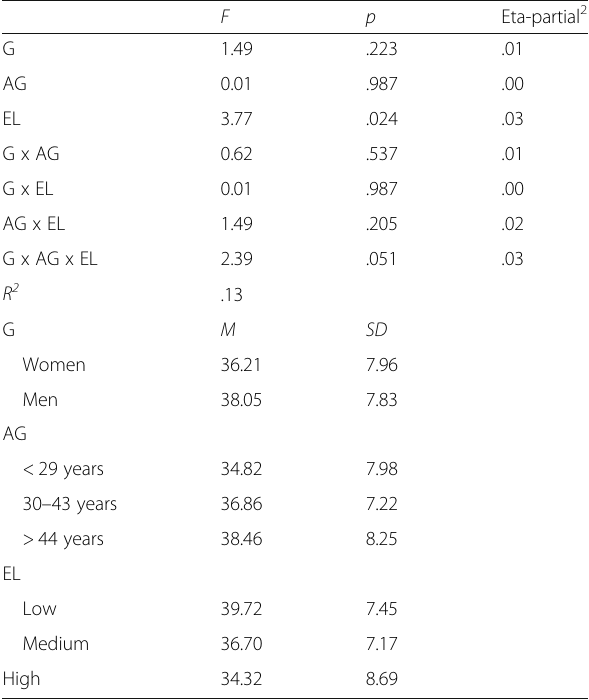
Table 3 Relation between sociodemographic characteristics and CENVE